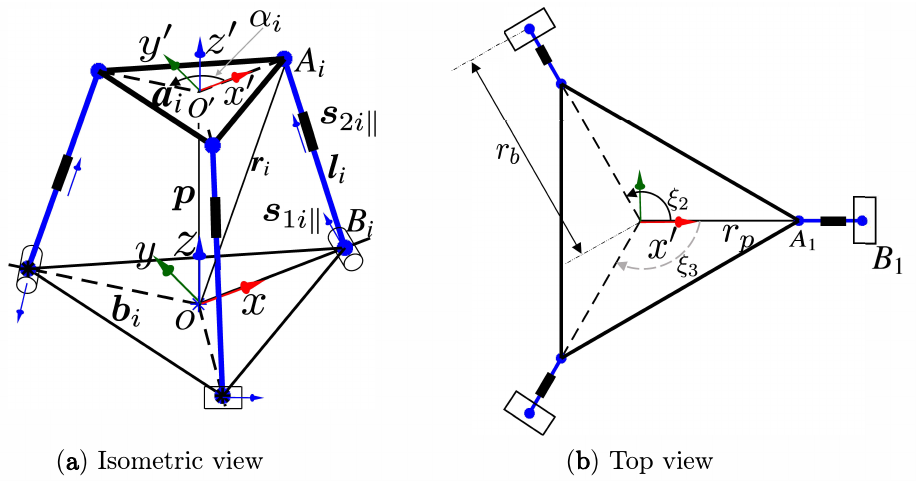
Figure 1. Kinematic architecture of the 3-RPS manipulator.